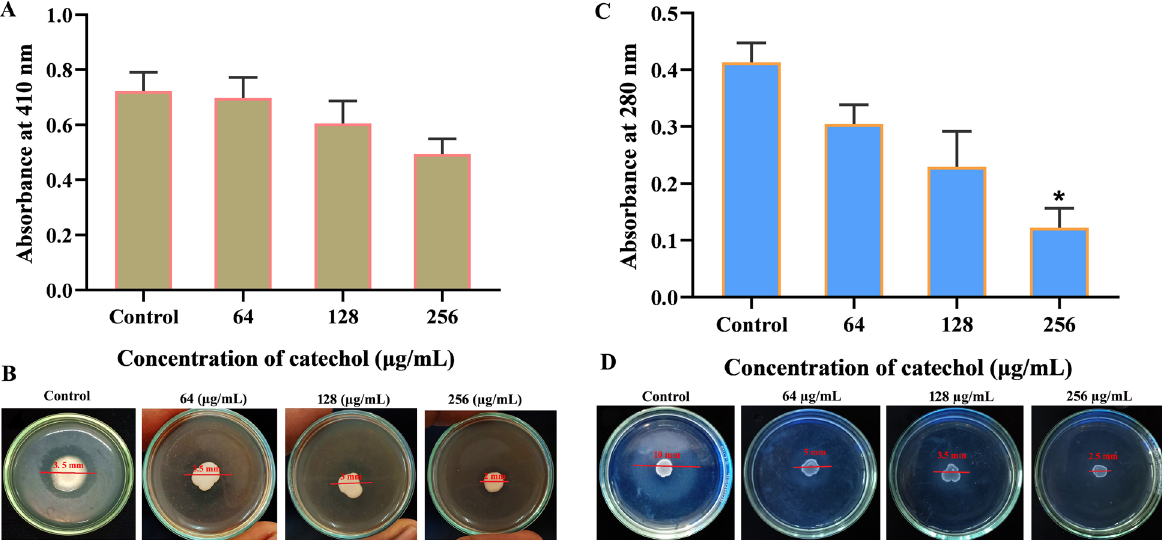
Figure 7. Impact of catechol on virulence enzyme production. ( A ) Quantification of C. albicans lipase production after 24 h treatment with catechol at the concentration of 64, 128 and 256 µg/mL. Error bars indicates the mean values of two experimental triplicates. ( B ) C. albicans culture was spotted on the plate supplemented with tributyrin in presence and absence of catechol to detect the lipase activity. ( C ) Quantification of C. albicans protease production after 24 h treatment with and without catechol (at 64, 128 and 256 µg/mL) using BSA as a substrate. Error bars indicates the two experiments triplicates. ( D ) Qualitative assessment of catechol inhibitory efficacy on the C. albicans protease production using BSA plate. Error bars indicates the mean values of two experiments triplicates. The “* “and “**” symbols represents the statistical significance of p < 0.05 and p < 0.01,